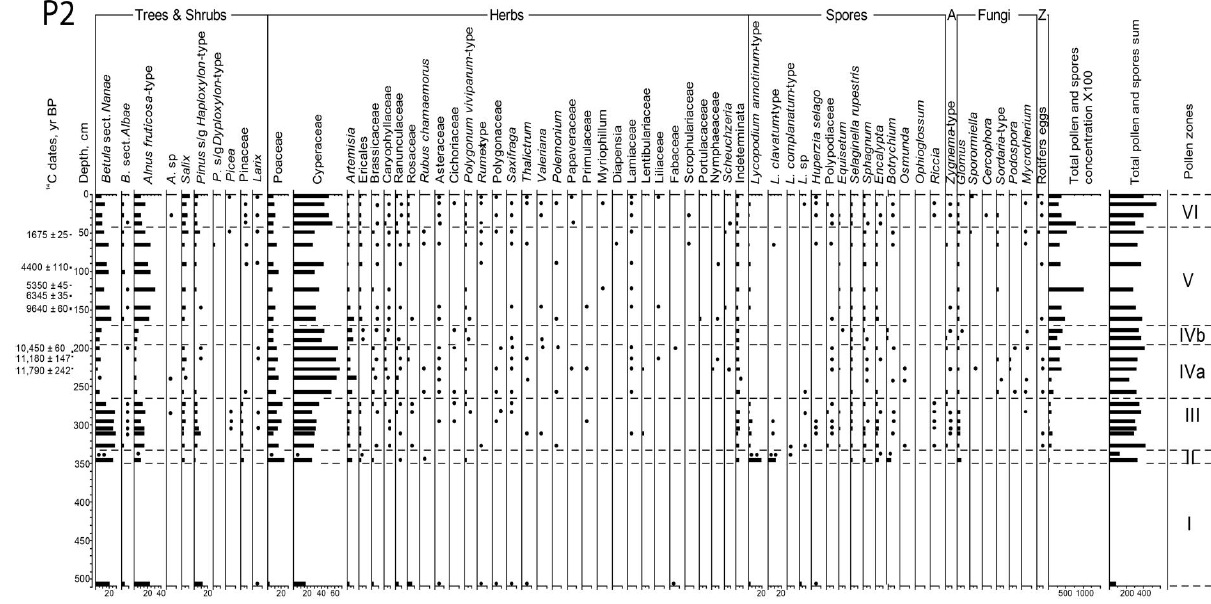
Fig. 4. Percentage pollen diagram of core P2. Dots are < 2% pollen contents.